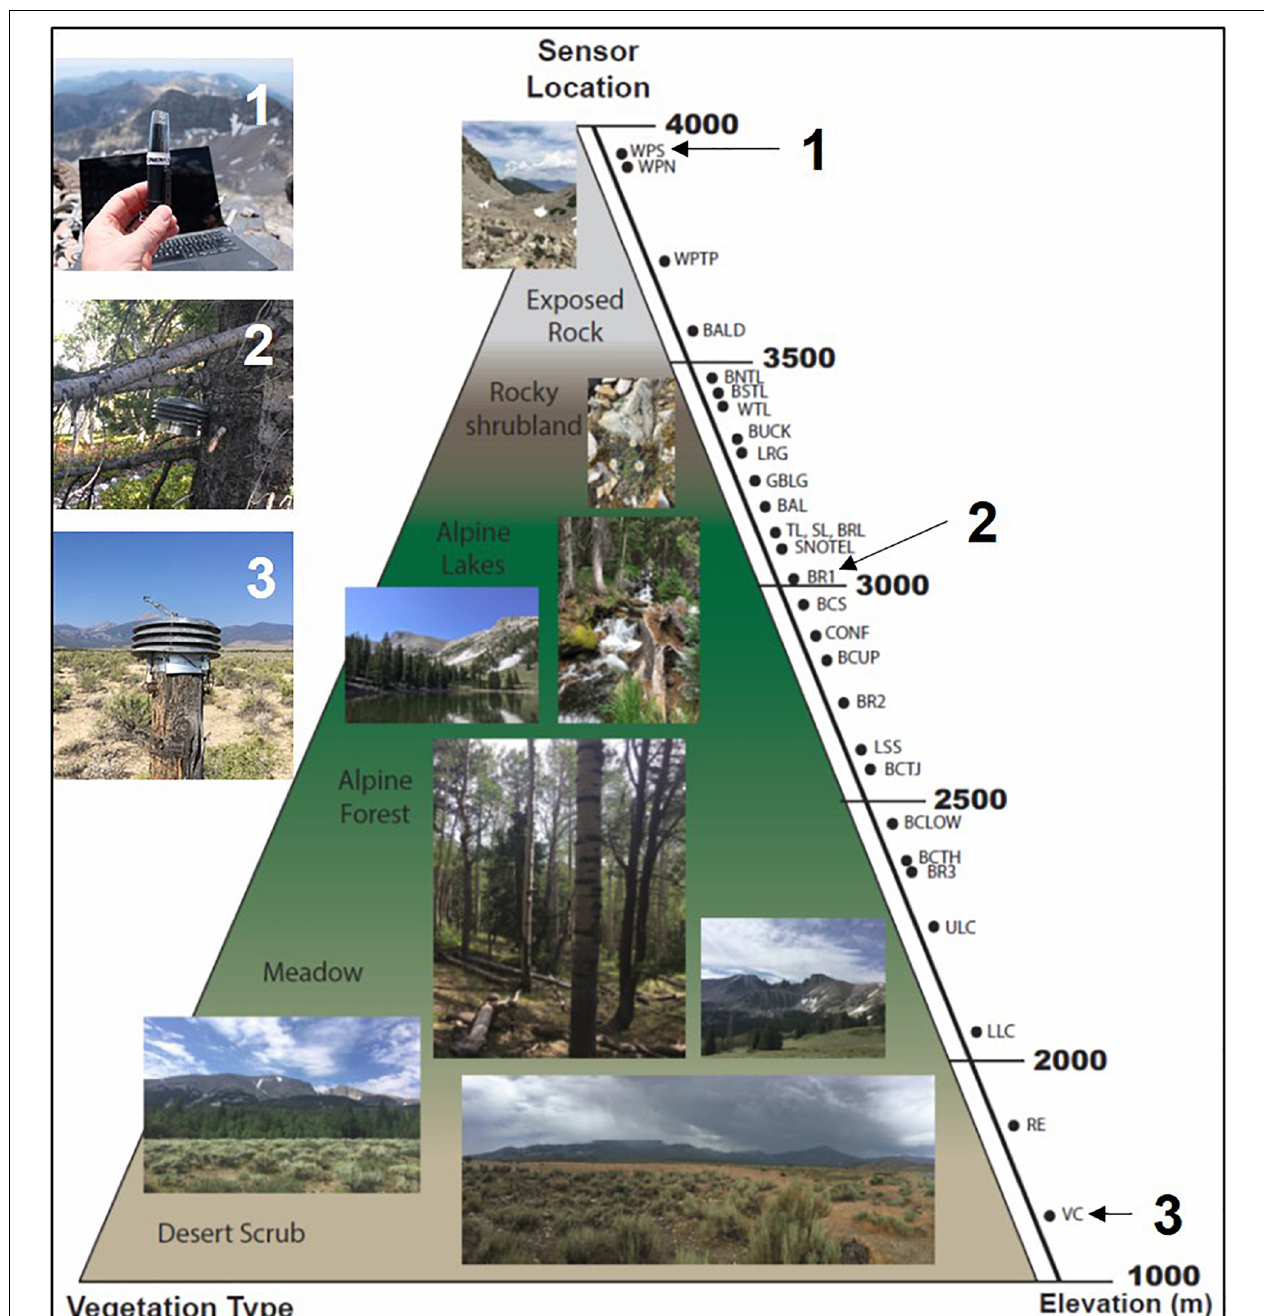
FIGURE 2 | Vertical schematic representing the ESN sensor location by elevation and ecosystem. Numbered panels show Lascar radiation shields for three locations, also identified by number and elevation: (1) WPS, 3976 m a.s.l.; (2) BR1, 3034 m a.s.l; and (3) VC, 1639 m